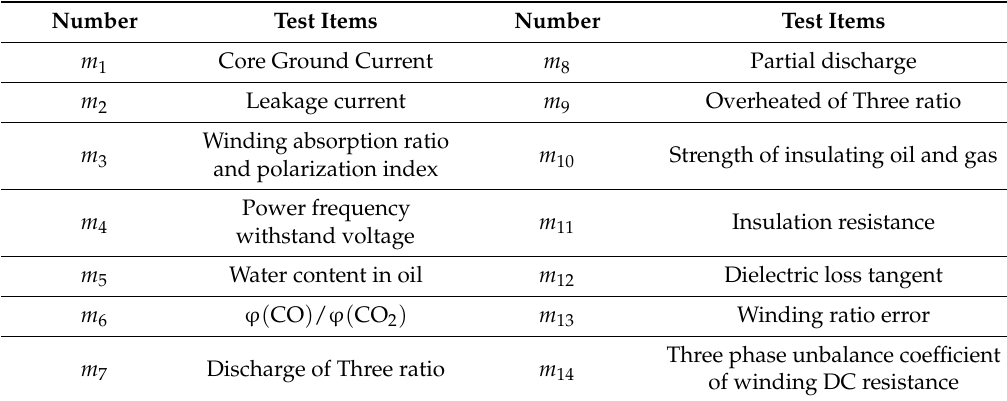
Table 3. Transformer test items.